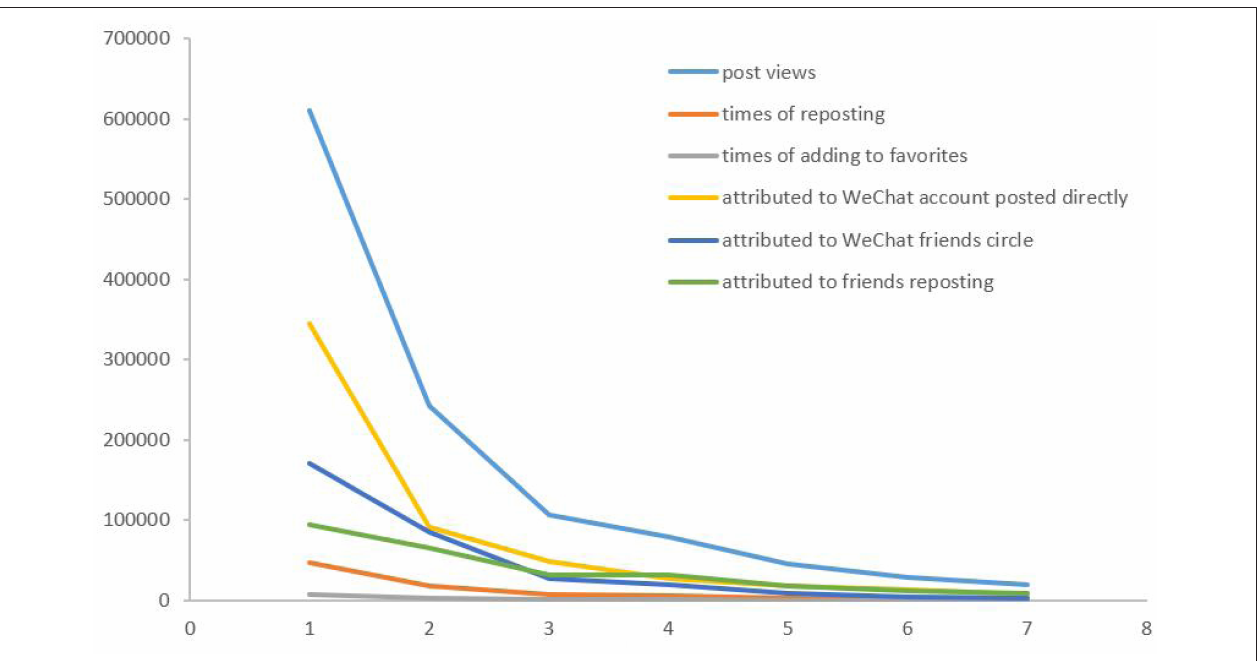
FIGURE 2 | Engagement of followers in the 7 days after the posts